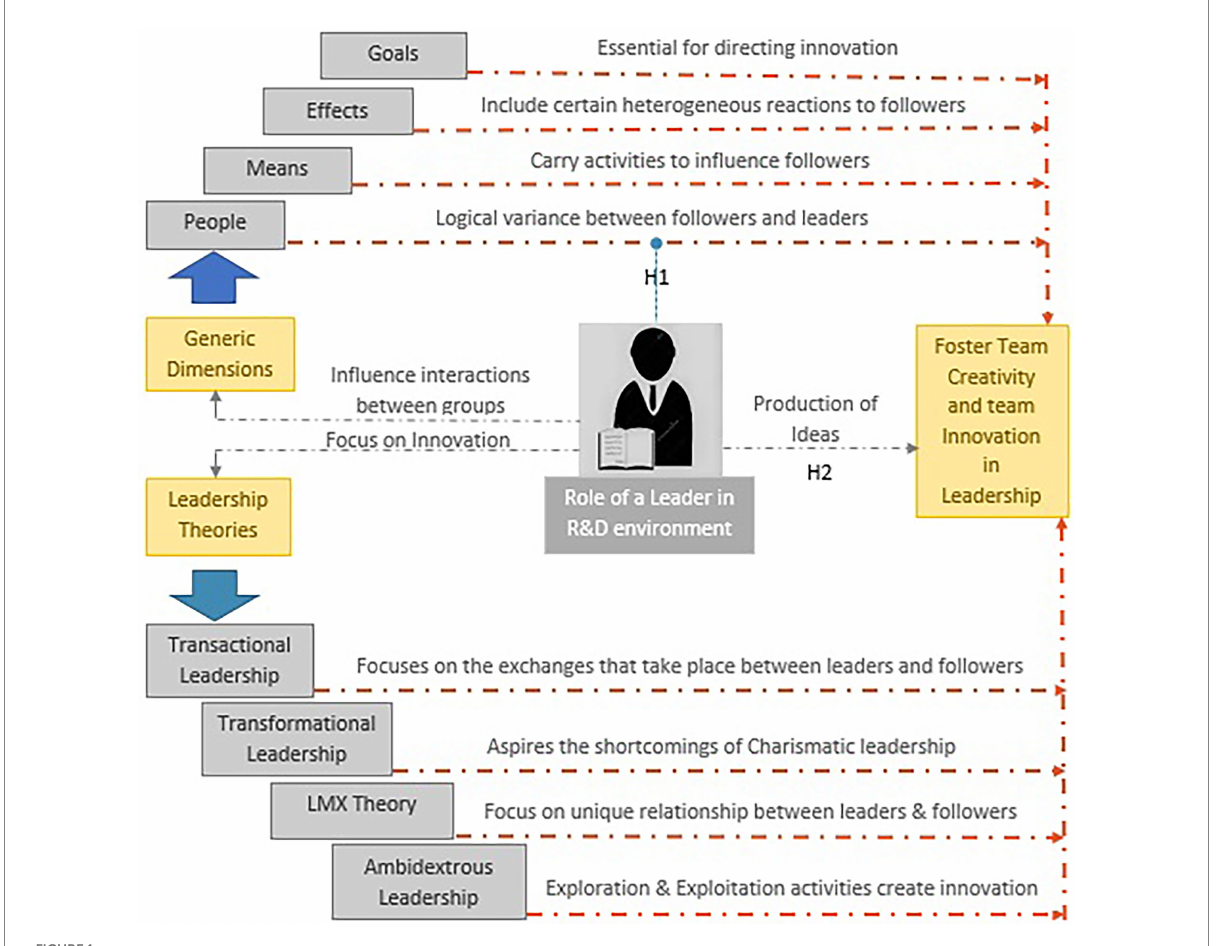
FIGURE 1 The role of a leader in R&D